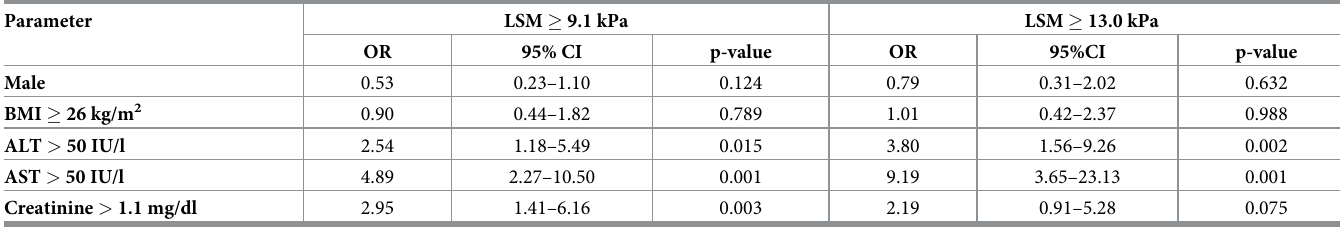
Table 3. Odds ratios for clinical and laboratory parameters regarding LSM.